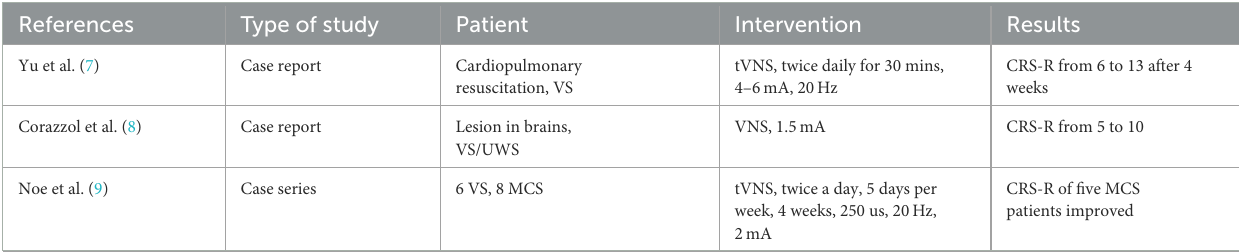
TABLE 1 Overview of the studies on vagus nerve stimulation for disorders of consciousness.